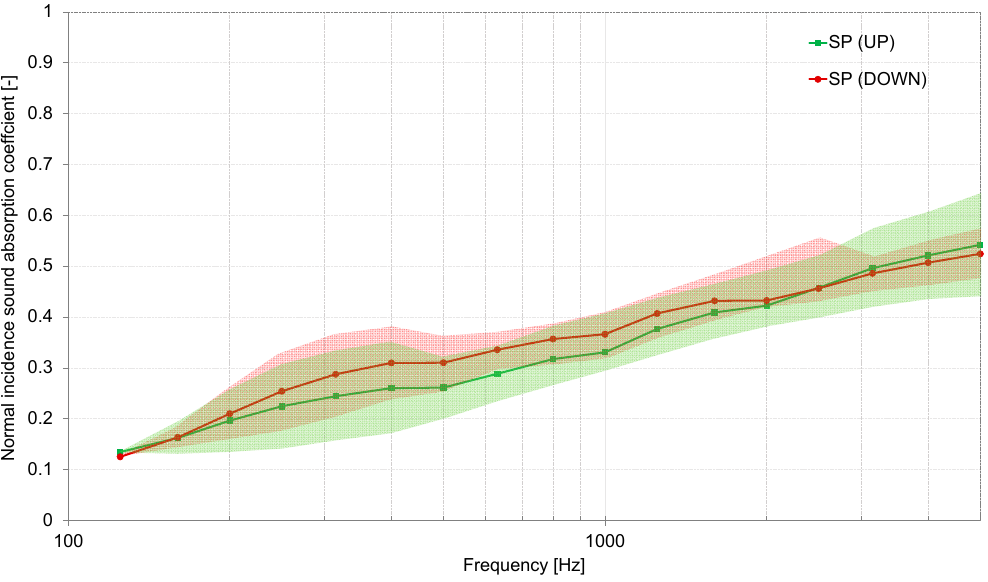
Figure 9. Normal incidence sound absorption coefficients experimentally measured (SP mix).